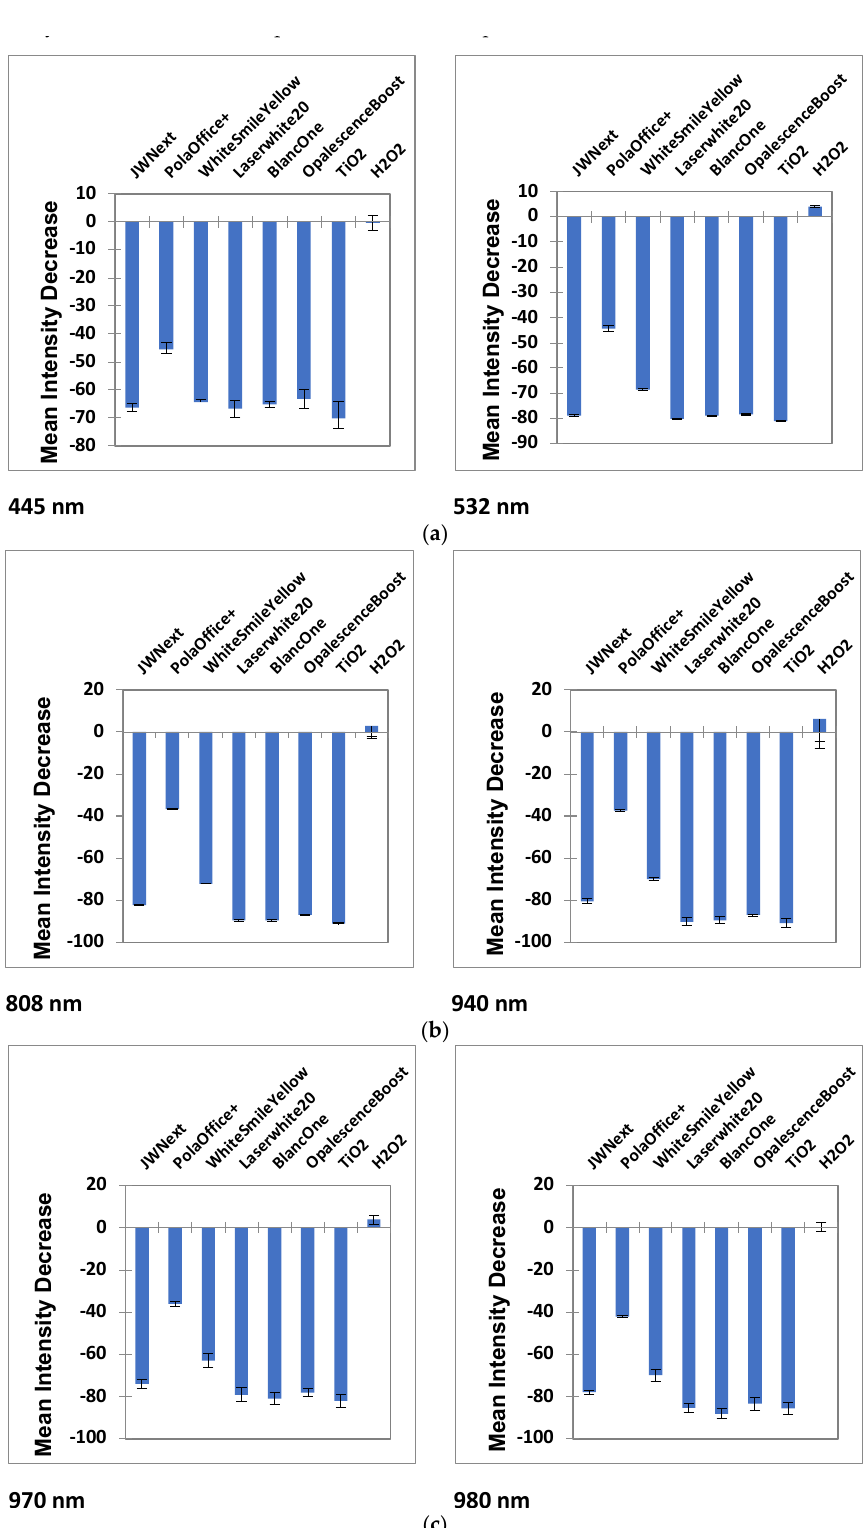
and 44% for all wavelengths, while WhitesmileYellow showed changes between 64% and 73%, respectively. As before, H 2 O 2 was presented to be transparent.